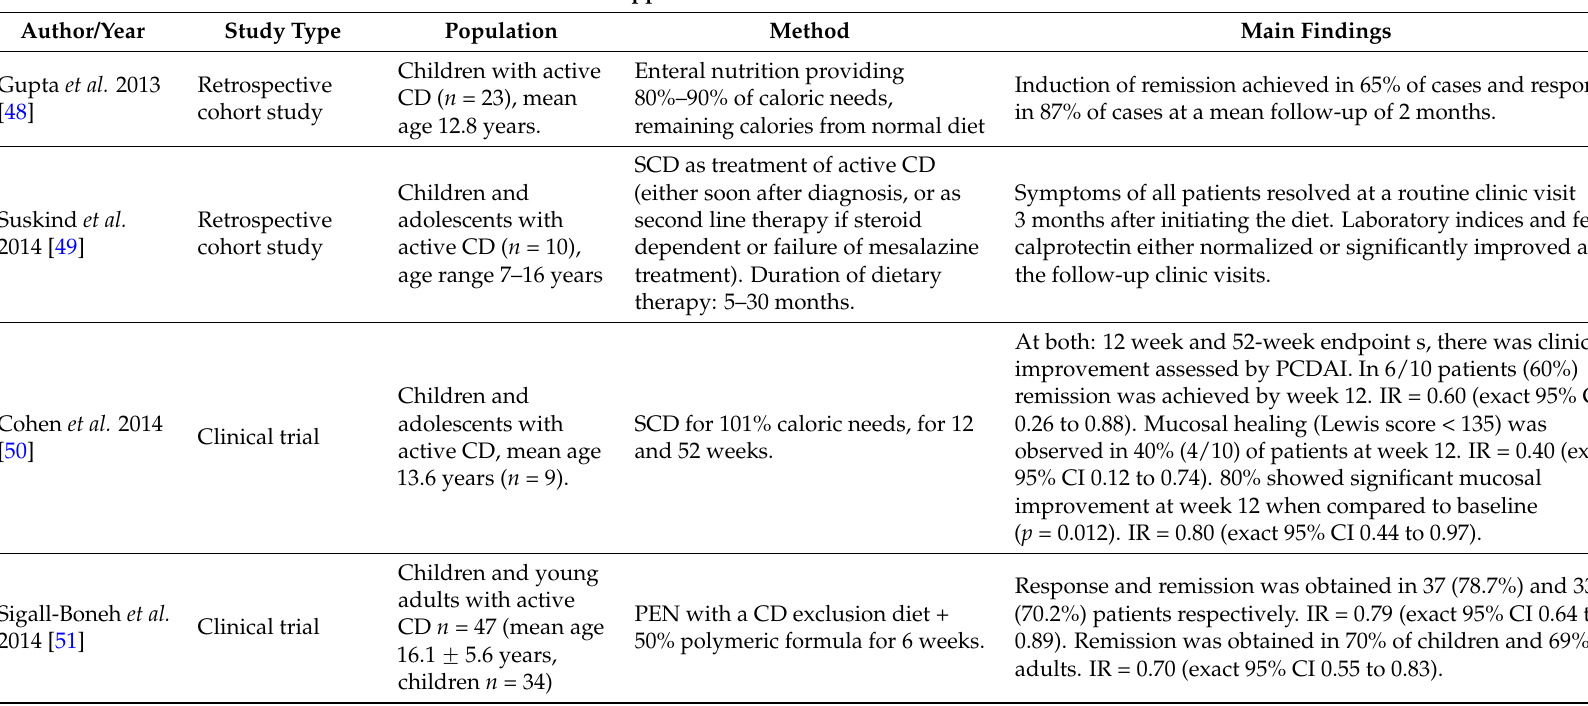
Table 5. Novel nutritional approaches for induction of remission in pediatric IBD. SCD = Specific Carbohydrate Diet. CD = Crohn’s Disease, PEN = partial enteral nutrition, PCDAI = Pediatric Crohn’s Disease Activity Index, IR = incidence